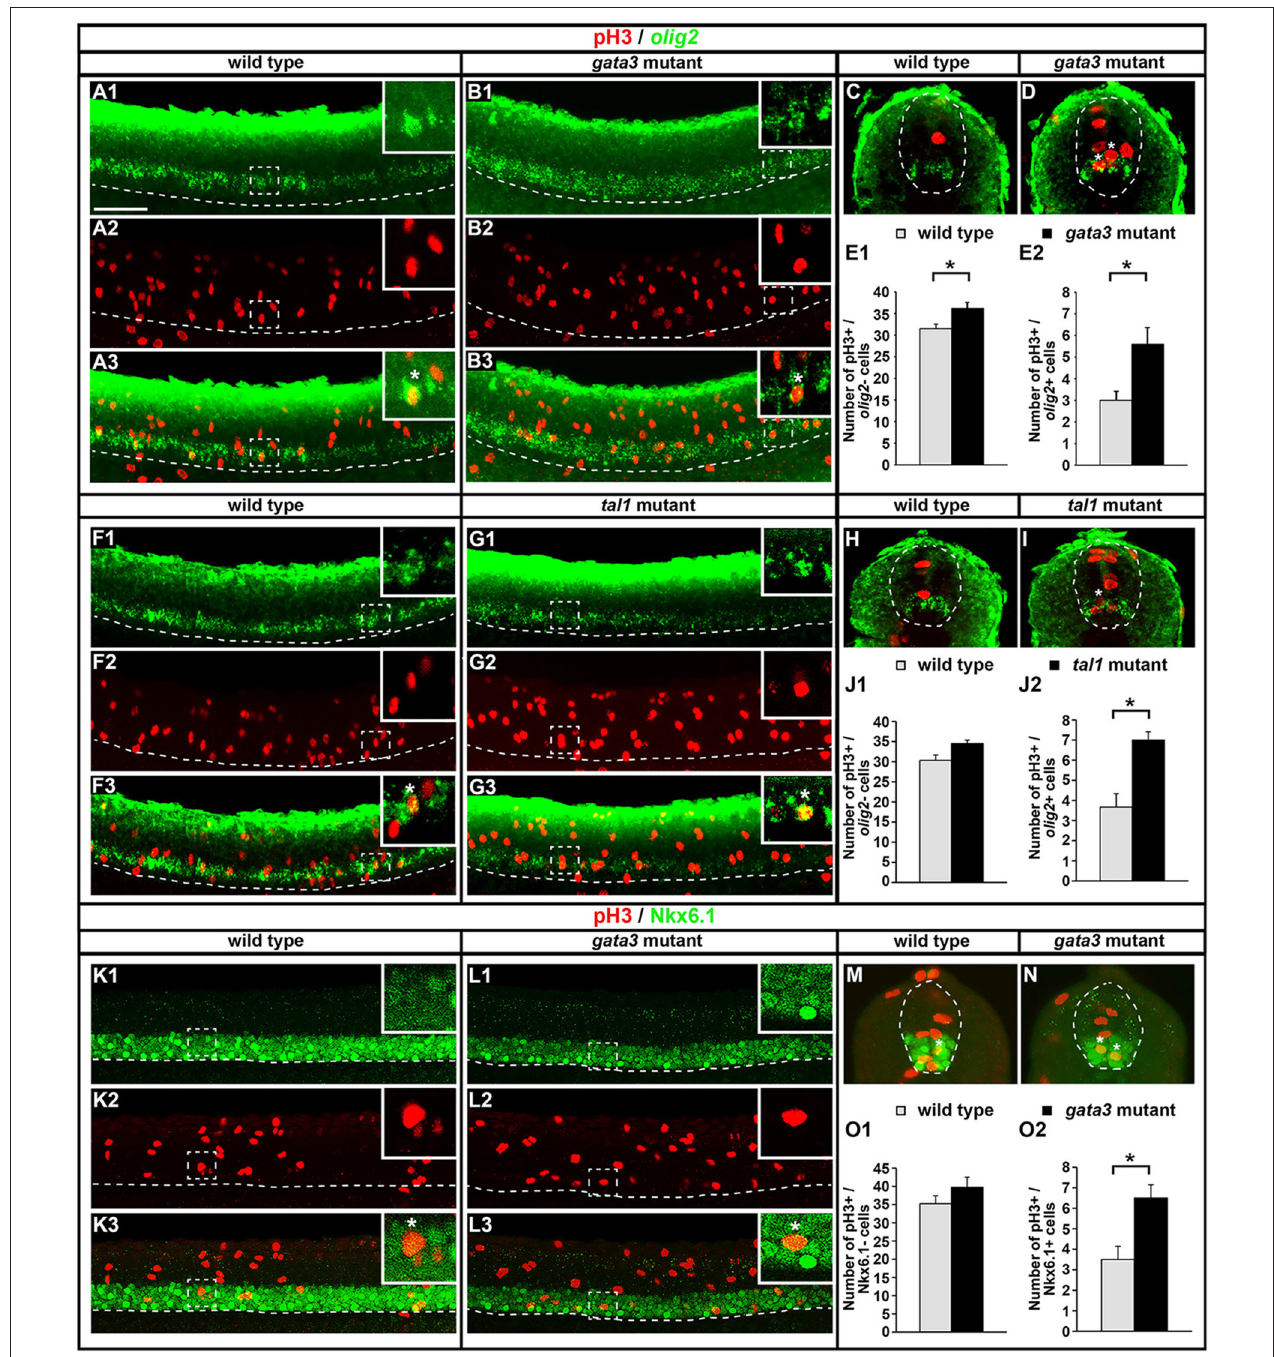
FIGURE 13 | Expression of pH3 and either olig2 or Nkx6.1 in tal1 and gata3 mutants. Lateral (A,B,F,G,K,L) and cross-sectional (C,D,H,I,M,N) views of pH3 (red) and either olig2 or Nkx6.1 (green) expression in WT embryos (A,C,F,H,K,M) , gata3 mutants (B,D,L,N) , or tal1 mutants (G,I) at 24h. Dorsal, top; in lateral views, anterior, left. White boxes in top right hand corners of lateral views are single confocal plane magnified views of the area indicated with a white dotted box. White stars indicate double-labeled cells. White dashed lines indicate the ventral limit of the spinal cord (lateral views) or the boundary of the spinal cord (cross-sections). For lateral views, single channel and merged images are shown. Scale bar = 50 microns. Mean number of pH3-positive; olig2 -negative cells (E1,J1) and pH3-positive; olig2 -positive cells (E2,J2) adjacent to somites 6–10 in WT and mutant embryos. Mean number of pH3-positive; Nkx6.1-negative cells (O1) and pH3-positive; Nkx6.1-positive cells (O2) adjacent to somites 6–10 in WT and mutant embryos. All counts are an average of at least 3 embryos. Cell rows were assigned based on average cell diameters. Error bars indicate SEM. Statistically significant comparisons are indicated with brackets and stars. * P < 0.05. For P- values see Supplementary Table 6.